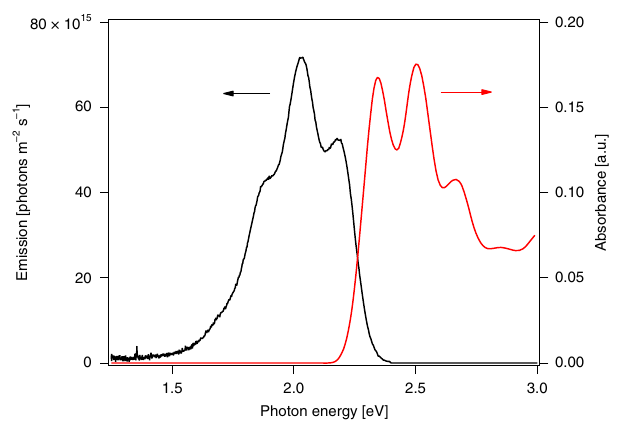
Fig. 1 EL spectrum for a rubrene/C 60 heterojunction as reported in the original manuscript for an applied voltage of 1.15 V. The emission at this level is 3 cd m − 2 . Also shown is the absorbance of a 40-nm-thick fi lm of